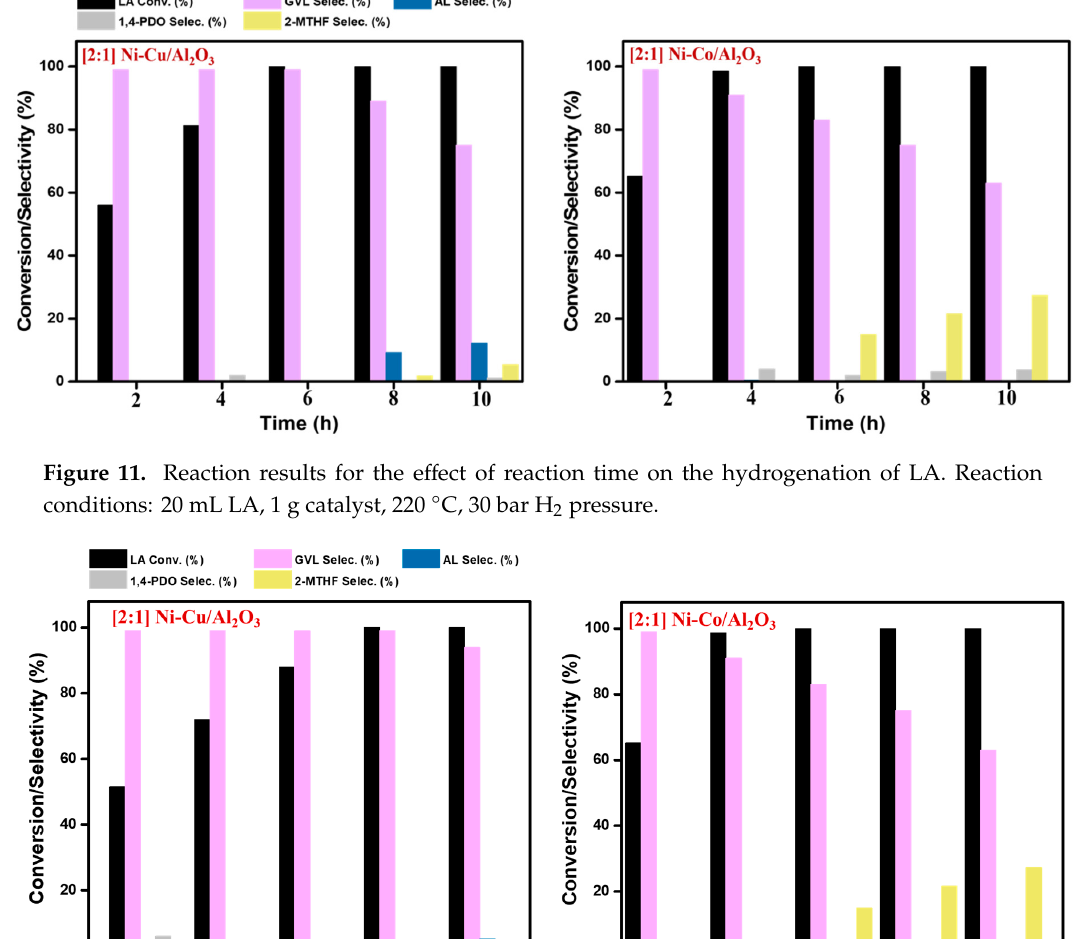
Figure 11. Reaction results for the effect of reaction time on the hydrogenation of LA. Reaction conditions: 20 mL LA, 1 g catalyst, 220 °C, 30 bar H 2 pressure.